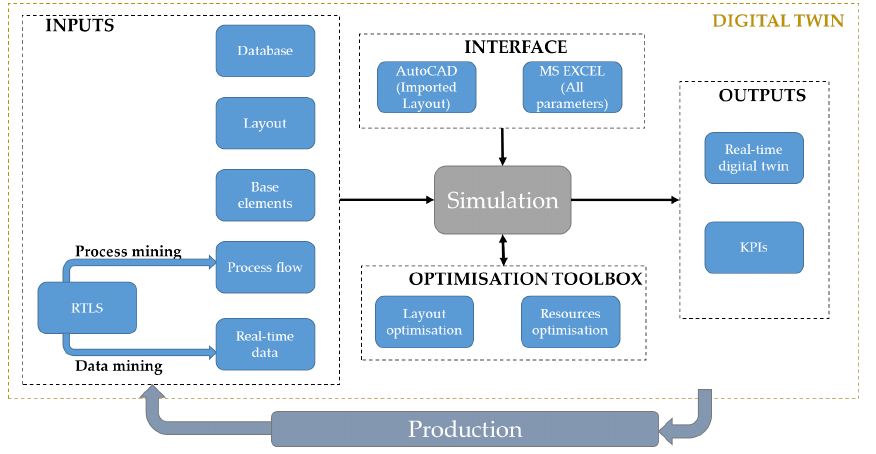
Figure 14. The developed framework of the real-time digital twin concept. The two main inputs of the simulation are the material flow (process model) and the real-time location system (RTLS)-based parameters of the